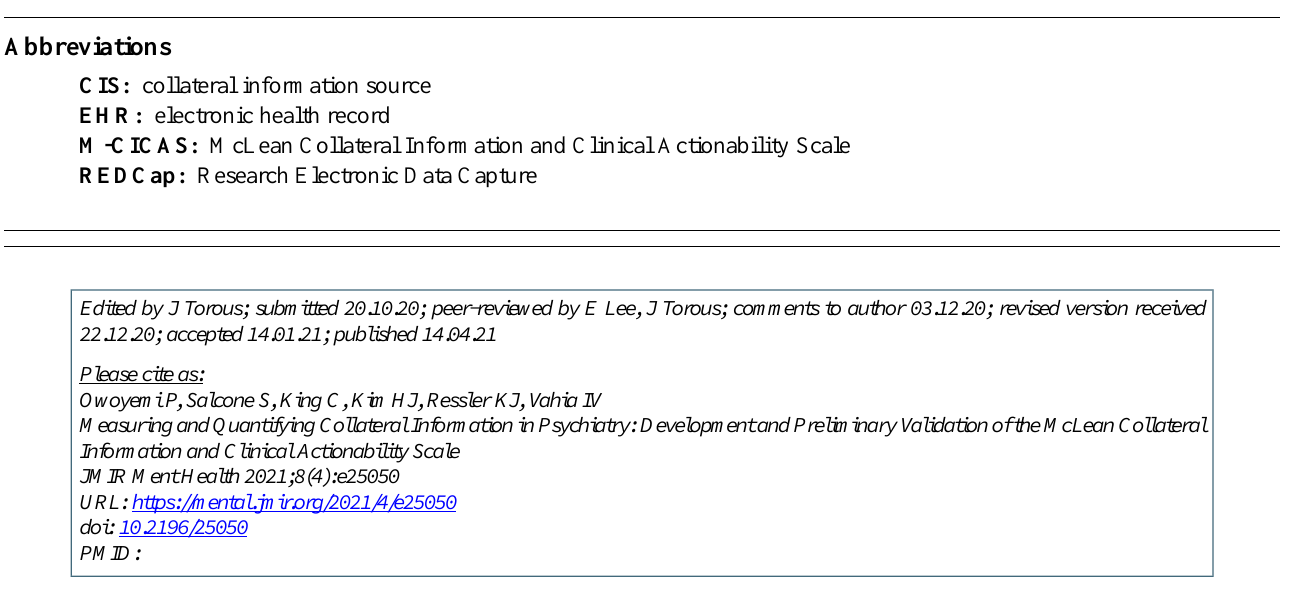
published in JMIR Mental Health (http://mental.jmir.org), 14.04.2021. This is an open-access article distributed under the terms of the Creative Commons Attribution License (https://creativecommons.org/licenses/by/4.0/), which permits unrestricted use, distribution, and reproduction in any medium, provided the original work, first published in JMIR Mental Health, is properly cited. The complete bibliographic information, a link to the original publication on http://mental.jmir.org/, as well as this copyright and license information must be included.